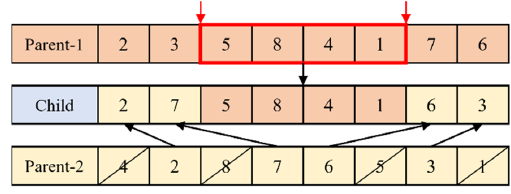
Figure 4. Crossover scheme.